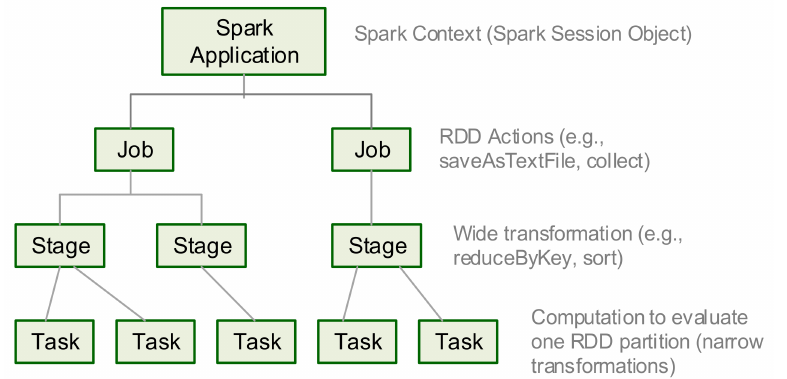
Figure 1. The Spark application tree [23].